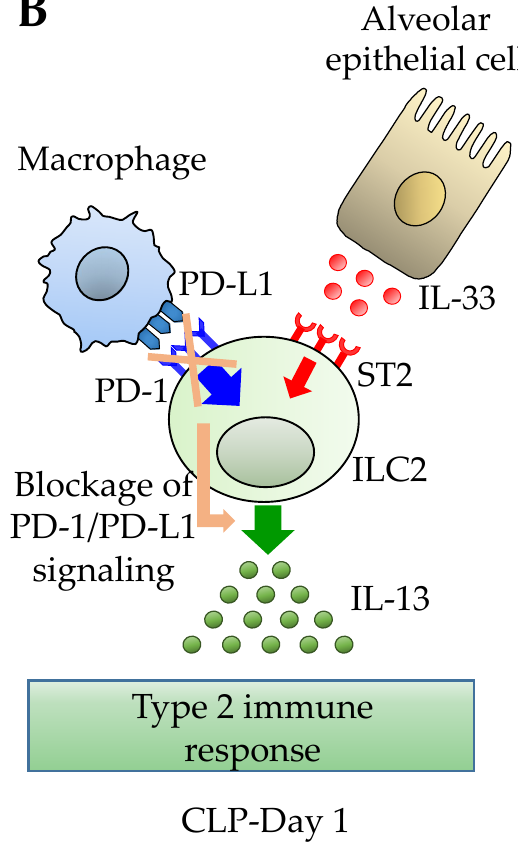
Figure 2. Schematic representation of a proposed model for ( A ) the balance between the ST2-IL-33 axis and the PD-1-PD-L1 axis, and ( B ) a novel therapeutic strategy for the septic lung by blocking PD-1 / PD-L1 signaling in ILC2s. ( A ) IL-33 released from damaged lung epithelial cells binds to ST2, leading to NF- κ B and AP-1 activation, which promotes IL-13 production in ILC2s (ST2-IL-33 axis; red arrows). In contrast, the PD-L1 upregulated in macrophages elicits PD-1-mediated inhibitory signals related to STAT5 inactivation. This inhibits IL-13 production in ILC2s (PD-1-PD-L1 axis; blue arrows). The balance of signaling strengths between the ST2-IL-33 axis and the PD-1-PD-L1 axis could determine the levels of IL-13 production in ILC2s. ( B ) Blocking PD-1 / PD-L1 signaling in ILC2s may induce IL-13 secretion, leading to impaired lung inflammation during sepsis. CLP: cecal ligation and puncture,